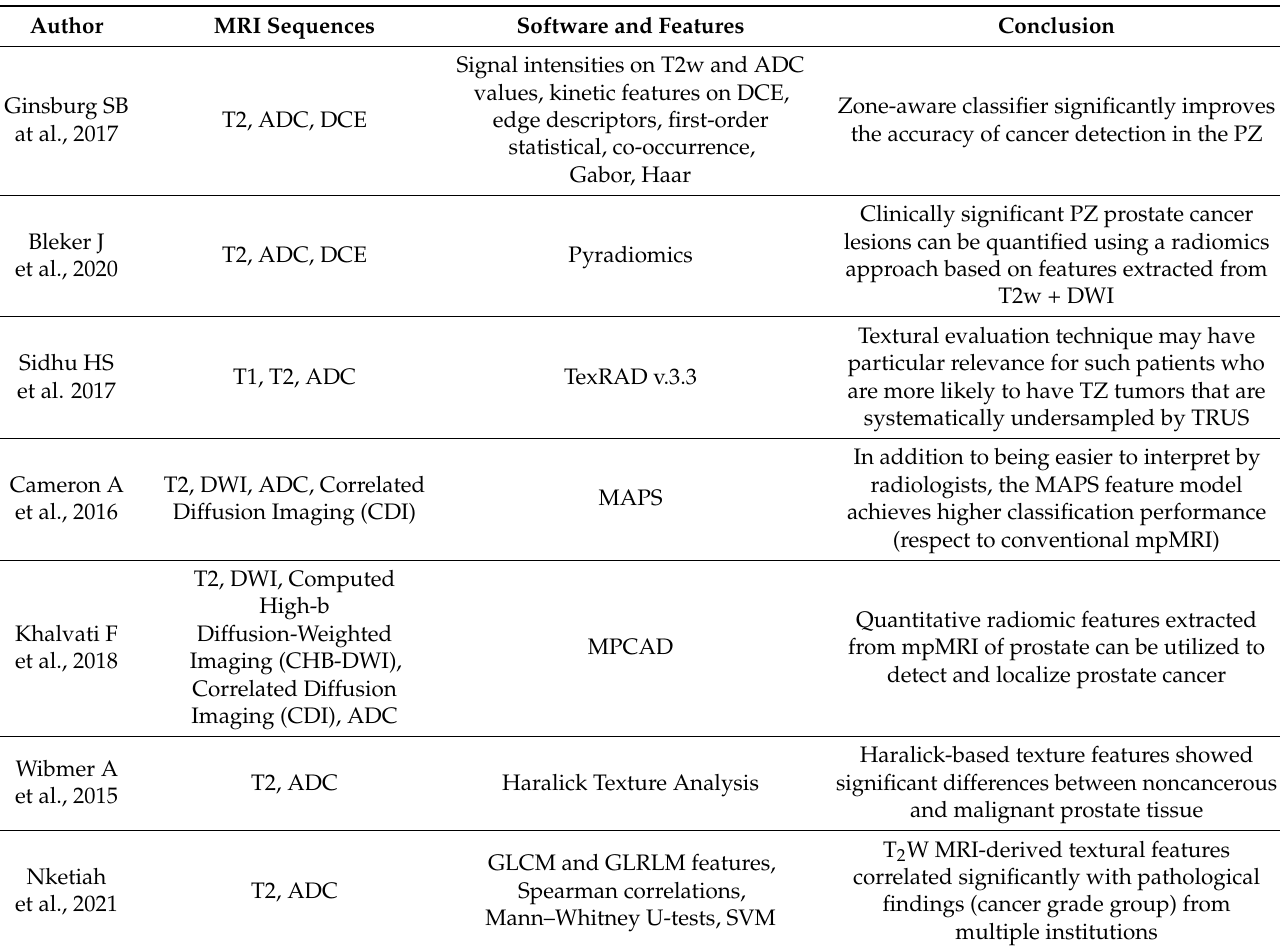
Table 1. Summary of radiomic manuscripts for detection and location of prostate